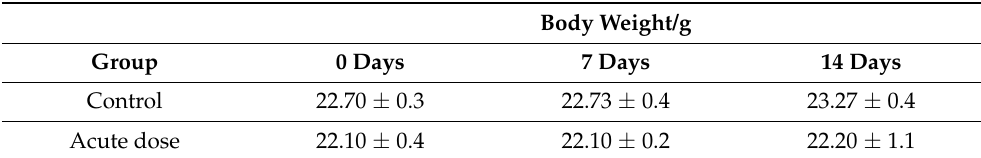
Table 5. Effect of administering a 2000 mg / Kg body dose of novel nutraceutical on body weight (g) in mice—acute toxicity testing.